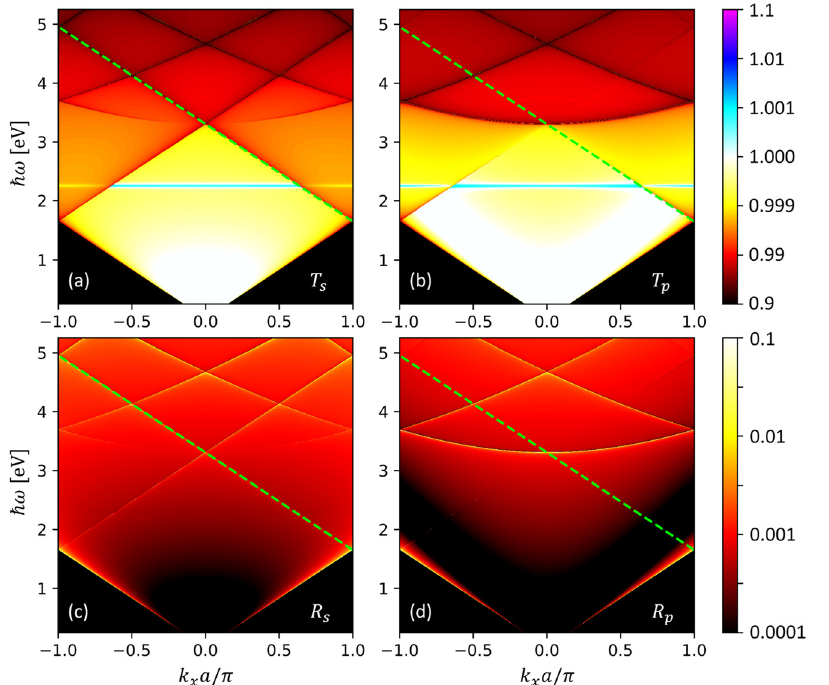
Figure 3: Zero-order transmission and reflection from a square lattice (pitch a = 250 nm, background index n d = 1.5) of spherical nanoparticles with gain (parameters as in Figure 2), as a function of frequency ω and in-plane momentum k x (for k y (cid:1) 0): (a, b) transmissivity T , (c, d) re fl ectivity R , for (a, c) s-polarized (TE), and (b, d) p-polarized (TM) incident light. Green dashed lines mark the (1, 0)-Rayleigh